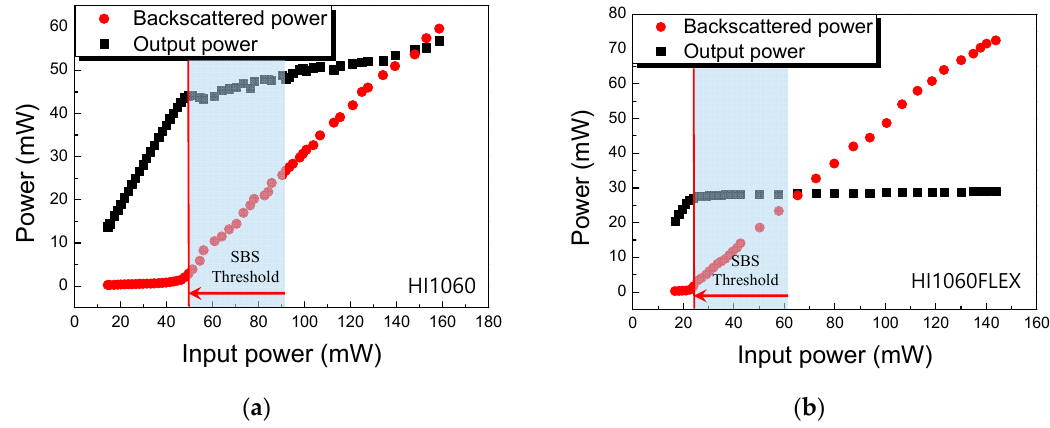
Figure 4. SBS threshold power measurements for ( a ) HI1060 fiber and ( b ) HI1060FLEX fiber.